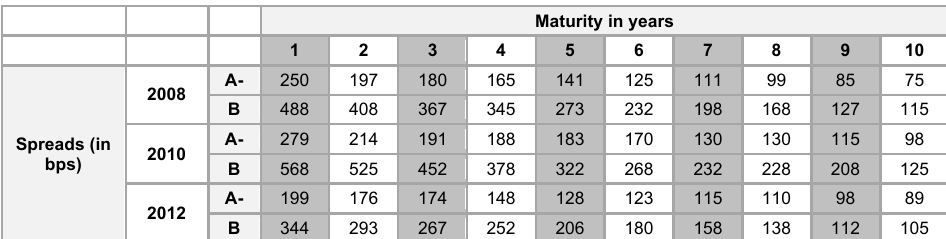
South African credit spreads for different credit quality